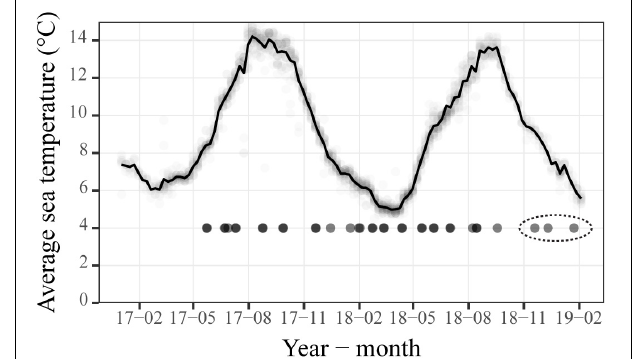
FIGURE 2 | Average sea temperature (at 3 m depth) for the Island Frøya. Temperature measurements for each salmon farm, downloaded from BarentsWatch, are shown by faint circles around the line. Days when planktonic sea lice were sampled are shown as black circles (at y = 4), and the dashed ellipse indicates samples taken during the fallowing period.